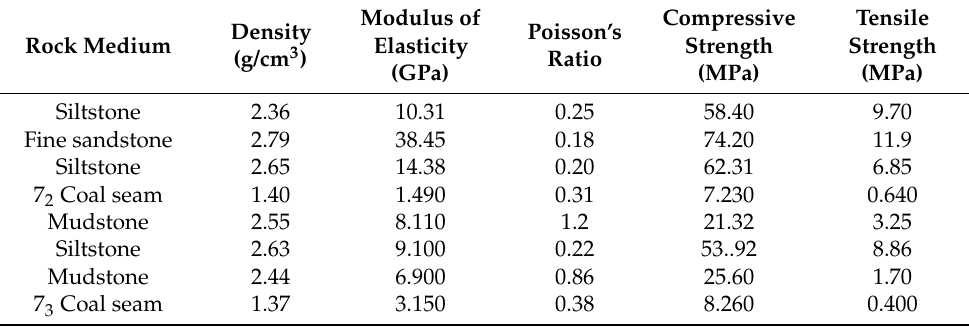
Figure 6. Histogram of the II7224N working face. The direct roof of the II 7 2 24N coal face was siltstone with an average thickness of 2.88 m, the basic roof was fine sandstone with an average thickness of 13.50 m, the lithologic was hard, and the unidirectional compressive strength was 74.2 MPa. The mechanical parameters of the prototype coal rock are presented in Table 3. The model was simplified during the test process, and the test material proportion parameters are listed in Table 4. Table 3. Mechanical parameters of the prototype coal and